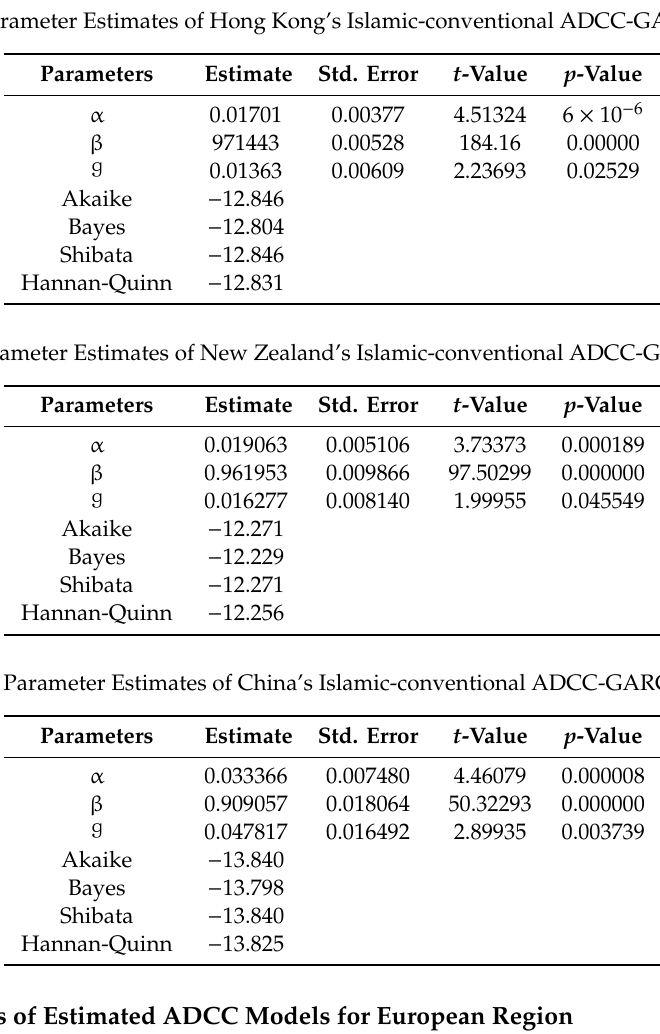
Table A3. Parameter Estimates of China’s Islamic-conventional ADCC-GARCH model. Table A2. Parameter Estimates of New Zealand’s Islamic-conventional ADCC-GARCH model. Table A4. Parameter Estimates of Ireland’s Islamic-conventional ADCC-GARCH model.